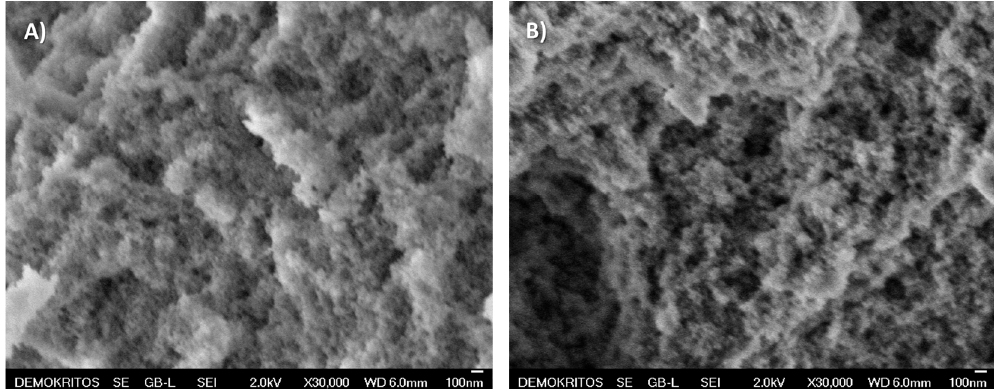
Figure 8. Scanning electron microscopy (SEM) micrographs of samples SiO 2 _Tris ( A ) and Cu_2.4 wt %_SiO 2 _Tris ( B ).